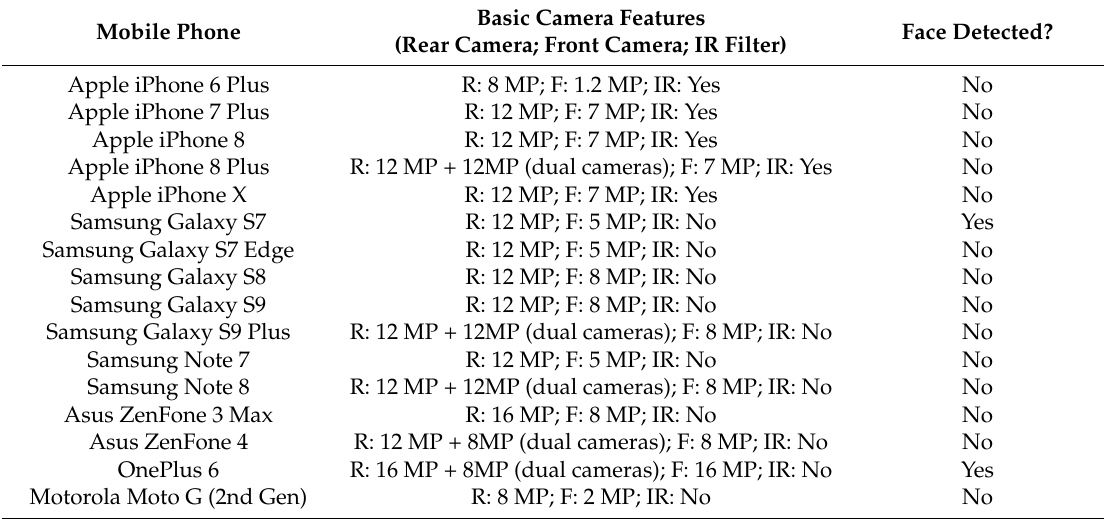
Table 4. Results from FacePET facial privacy protection with different rear-facing cameras and OpenCV face detection library. FacePET wearable with green LEDs.